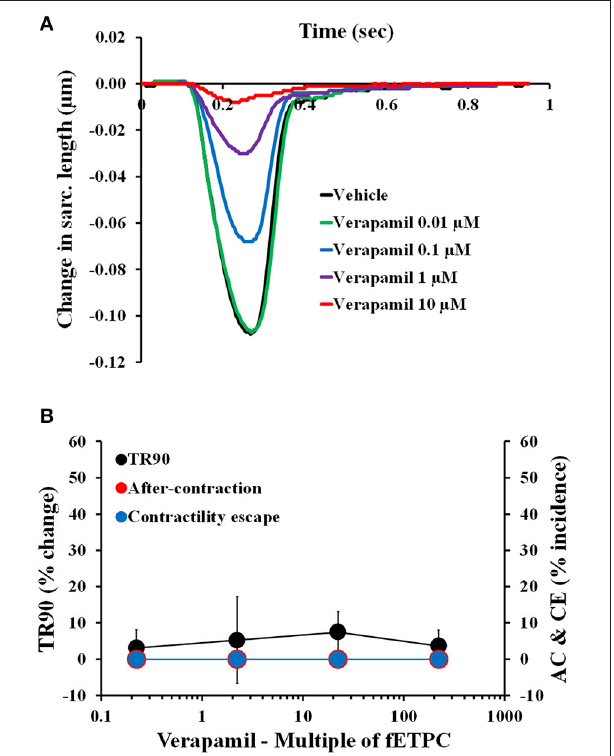
FIGURE 6 | (A) Typical non-fitted averaged contractility transients recorded from an adult human primary ventricular myocyte in the presence of vehicle control and after exposure to verapamil at 0.01, 0.1, 1, and 10 µ M (0.2-, 2-, 22-, and 222-fold the fETPC, respectively) at a pacing frequency of